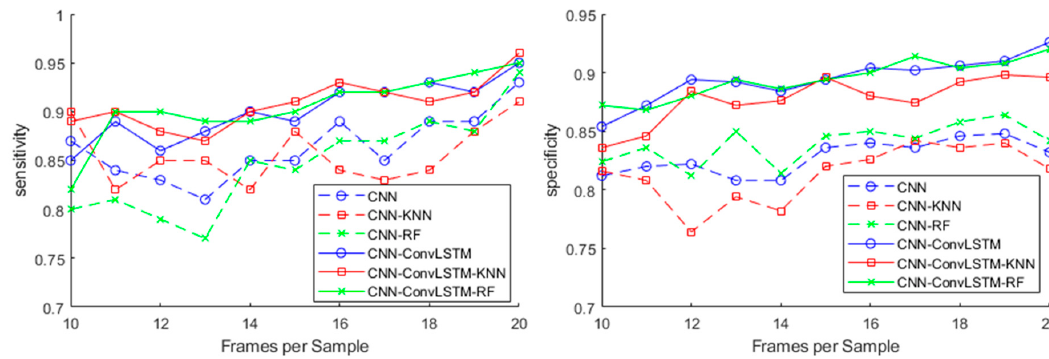
Figure 8. The effect of frames per sample on the sensitivity and specificity of the methods. Figure 8. The e ff ect of frames per sample on the sensitivity and specificity of the methods.